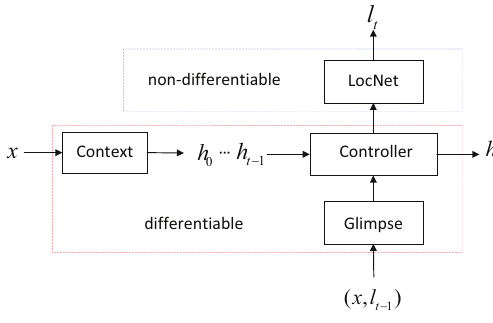
Figure 2. Flow chart of RAM, the hard attention model used in our adaptation